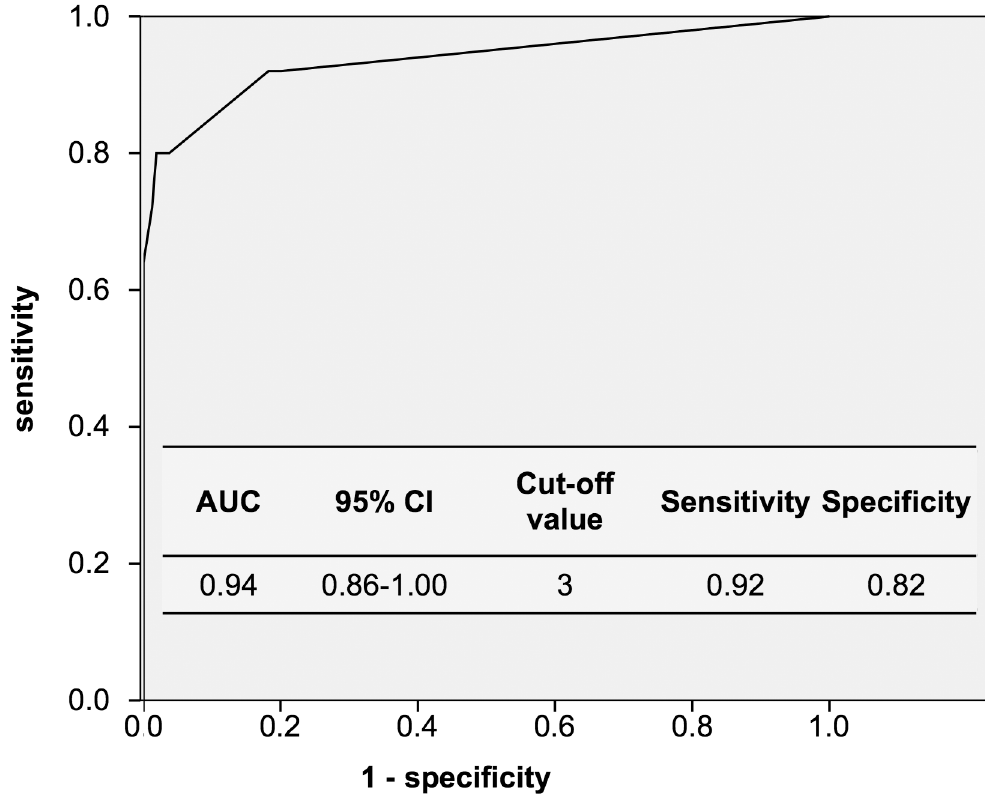
Area under the ROC curve for PDVFS was 0.94 (95% confidence interval: 0.86–1.00). At a cutoff value of 3, the optimal sensitivity and specificity were 0.92 and 0.82, respectively (Fig 2).